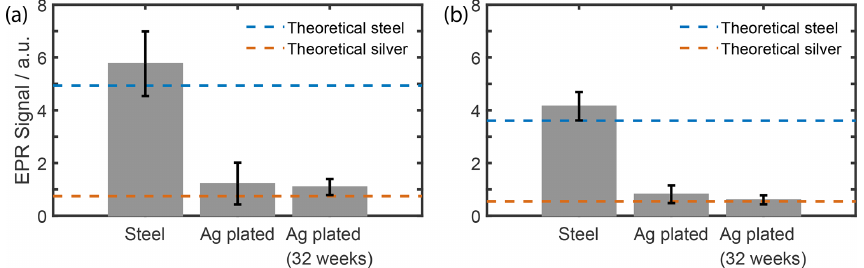
Figure 5. Microwave attenuation before and after plating of (a) 65.5cm steel waveguide at 197GHz and (b) 34cm steel waveguide at 94GHz. The dotted lines indicate the theoretical attenuation (Zinke, 1990) of a WR28 waveguide made from pure steel or pure silver.